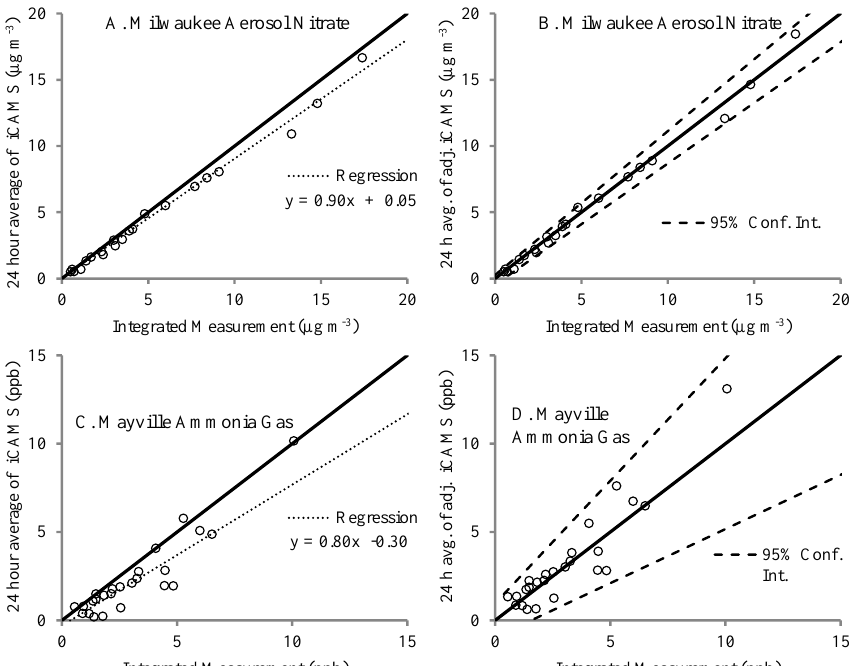
Fig. 3. Examples of iCAMS data before and after adjustment by linear regression against 24h integrated filter values. As an example of a sample with good agreement between continuous and integrated methods, total nitrate from Milwaukee (panel A ) is shown. The revised values (panel B ) are shown together with a 1 : 1 line and confidence intervals. As an example of a case with more bias and scatter, Mayville gas phase ammonia comparison between averages of iCAMS data and denuders is shown before (panel C ) and after (panel D ) adjustment.